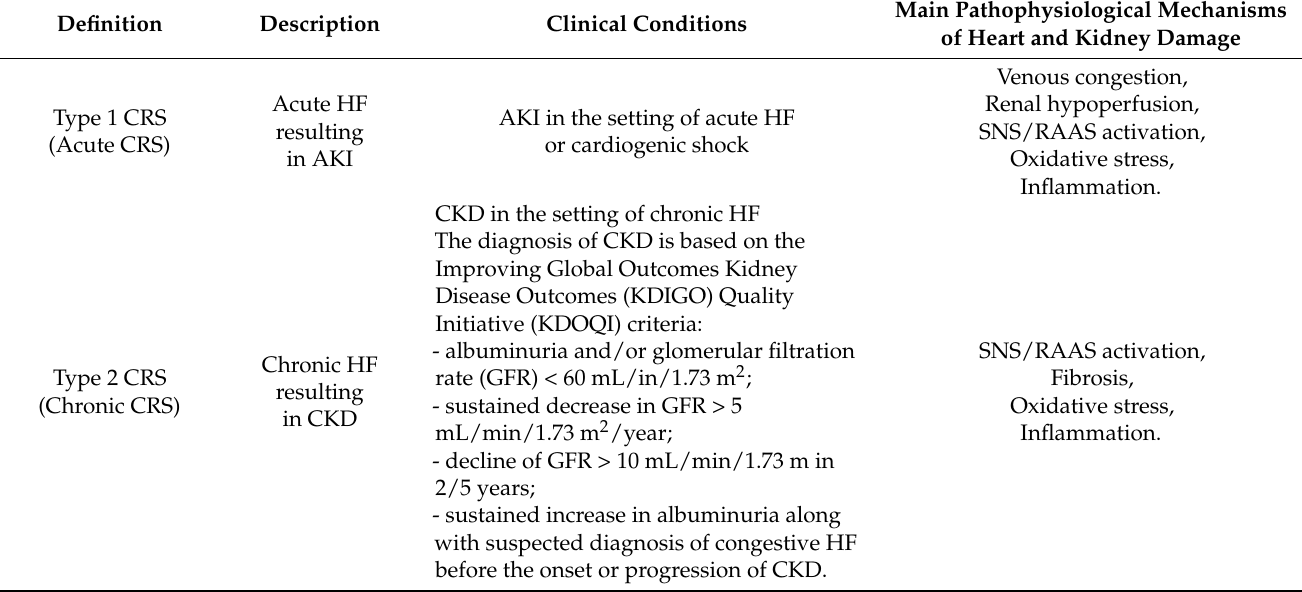
Table 1. Classification of cardiorenal